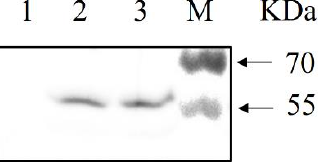
Figure 2. Western blotting for the detection of COE protein. A protein band of approximately 59 kDa corresponding to COE was detected using rabbit anti-COE monoclonal antibody (Lanes 2 and 3). Lactobacillus johnsonii as the negative control (Lane 1). The band size was consistent with the expected size.